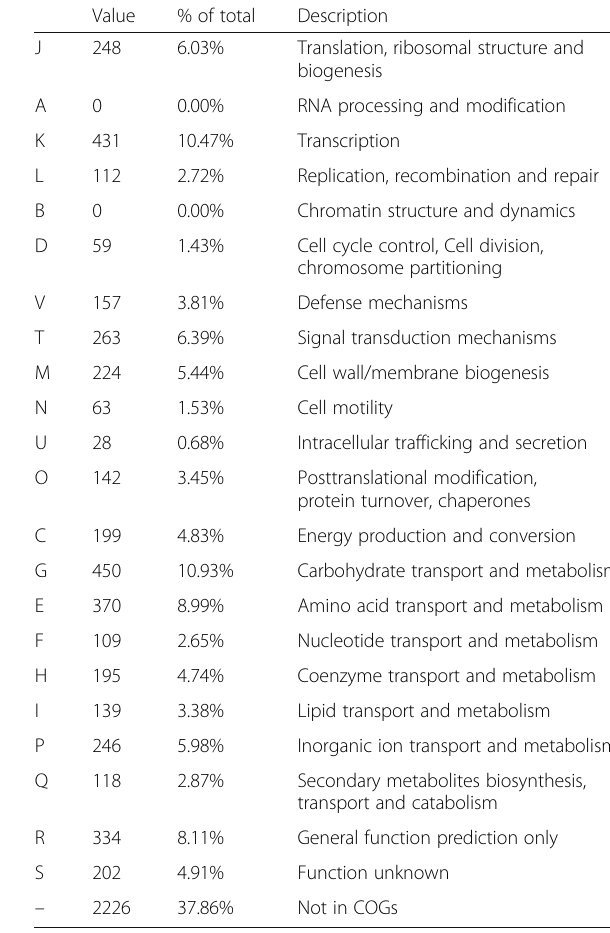
Table 6 Number of genes associated with general COG functional